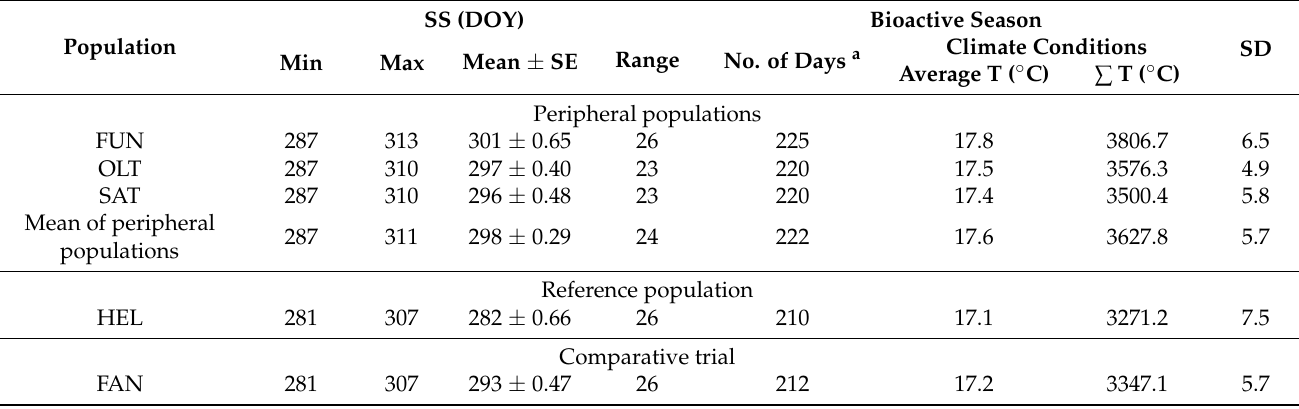
Table 7. Representative values of leaves senescence and bioactive season date observed for sessile oak in the studied populations and the FAN comparative